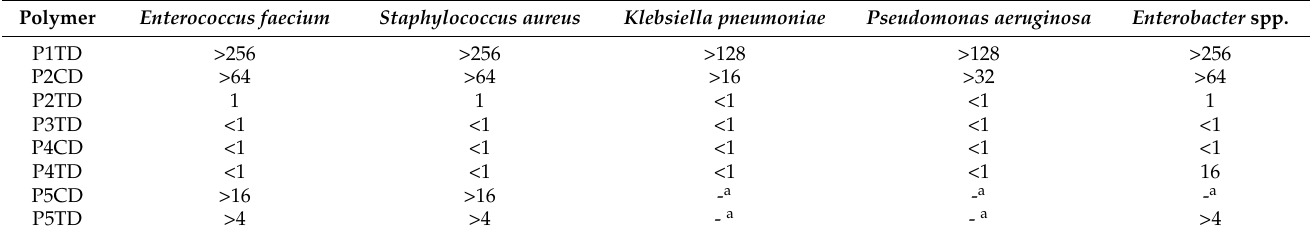
Table 4. HC50/MIC ratio of polycationic polymers.